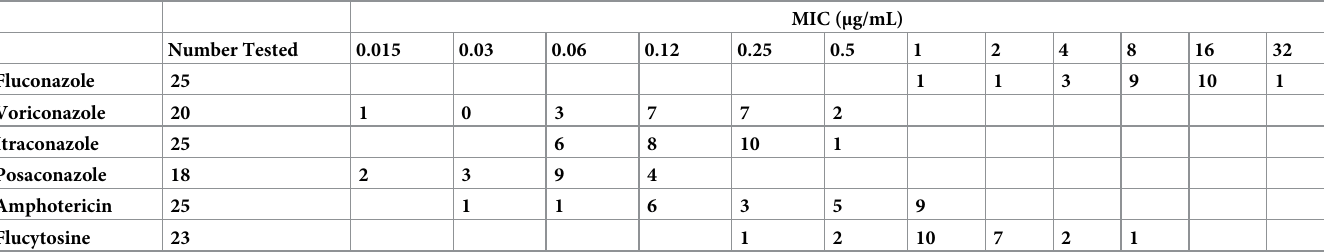
Table 3. Antifungal susceptibility.